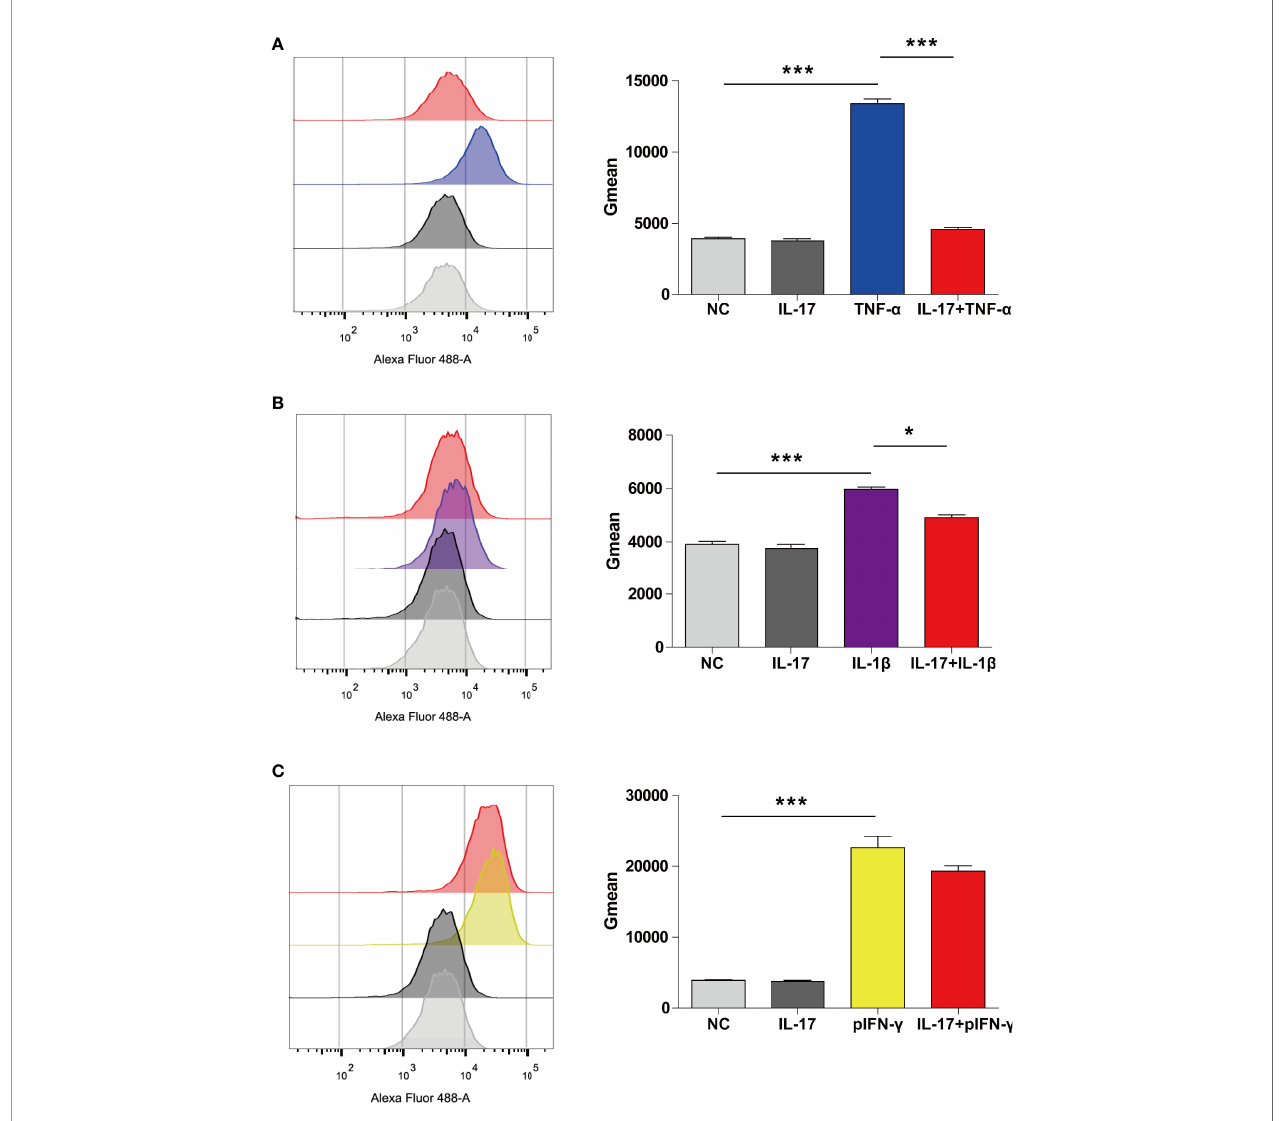
FIGURE 6 | IL-17 decreased TNF- a - or IL-1 b -induced SLA-I expression in porcine aortic endothelial cells (PAECs). (A) The PAECs were untreated or treated with rhIL-17 (100 ng/ml), rhTNF- a (2 ng/ml) or rhIL-17 plus rhTNF- a for 24 h, and the expression of SLA-I was measured via fl ow cytometry. (B) The PAECs were untreated or treated with rhIL-17 (100 ng/ml), rhIL-1 b (20 ng/ml) or rhIL-17 plus rhIL-1 b for 24 h, and the expression of SLA-I (A) was measured via fl ow cytometry. (C) The PAECs were untreated or treated with rhIL-17 (100 ng/ml), rpIFN- g (40 ng/ml) or rhIL-17 plus rpIFN- g for 24 h, and the expression of SLA-I was measured via fl ow cytometry. The degree of SLA-I binding to PAECs was evaluated by determining the geometric mean fl uorescence intensity (Gmean). Data are representative of at least three independent experiments (mean ± SEM). * p < 0.05, *** p < 0.001, determined by Student ’ s t